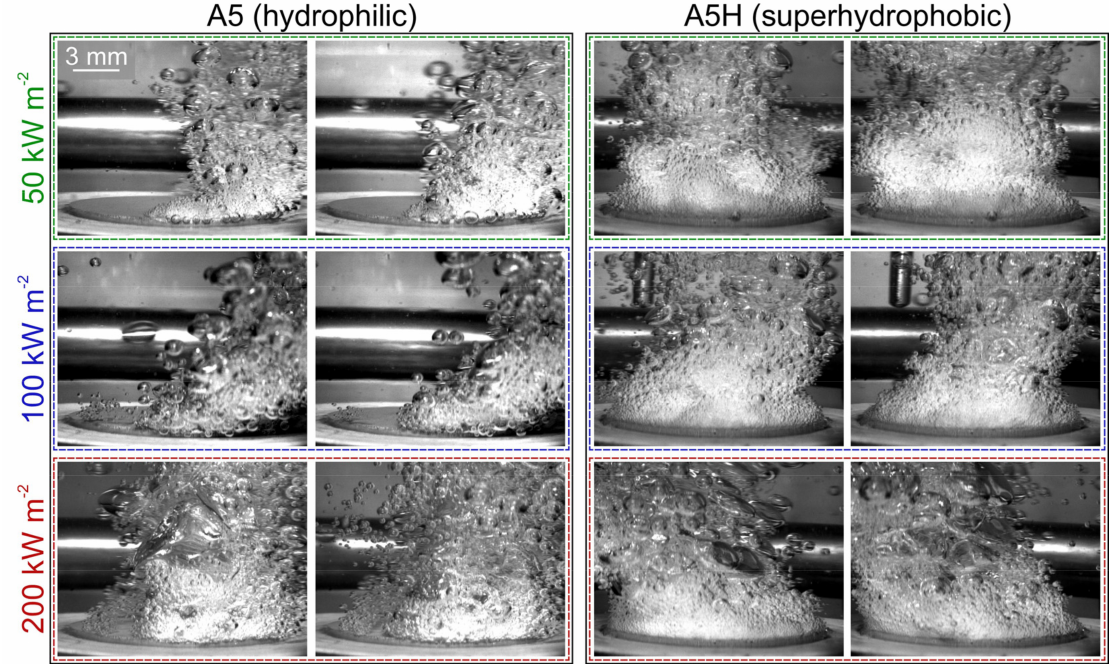
Figure 12. High speed snapshots of the boiling process on the A5 ( left column ) and A5H ( right column ) surfaces at three different heat fluxes during boiling of 6 wt.% 1-butanol